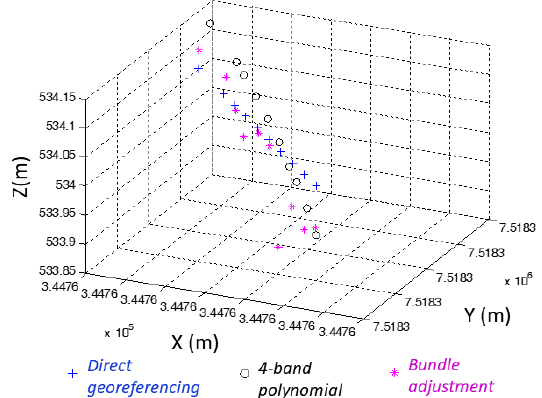
Figure 7. Example of a cube showing ten band positions estimated by BA, direct georeferencing and